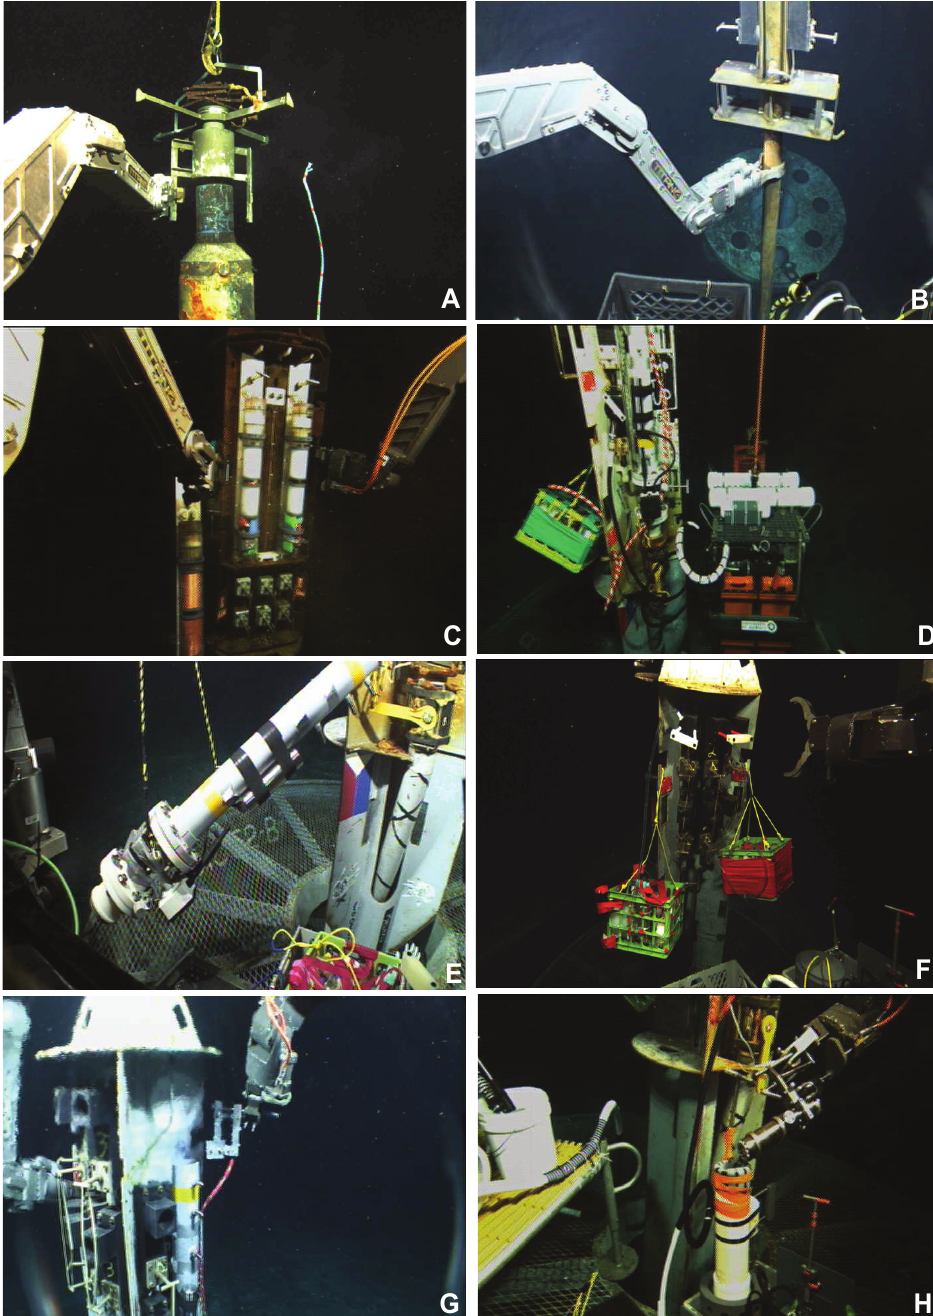
Figure 3. Photographs of CORK servicing activities during Expedition AT18-07. [A] Top Hat Extraction Tool deployed on old CORK wellhead in Hole 1027C. This tool is being used to remove an old electrical connector that was corroded in place, blocking access to the data logger. [B] Manifold insert being carried to CORK in Hole 1027C after removal of old connector and data logger. This tool has valves and fitting for pressure monitoring and a large ball valve and ring clamp (Fig. 2e) that can be used for later instrument deployments. [C] Exchanging OsmoSamplers on CORK in Hole U1301B. Samplers are (left to right): copper (gas tight), geochemistry (Teflon), microbiology. [D] OsmoSamplers in milk crate and GeoMICROBE sled deployed on ROV platform in Hole U1362B. [E] Flowmeter being lifted for deployment on Hole U1362B. [F] Multiple OsmoSampler crates deployed on CORK in Hole U1362A. [G] Fluid sampling inlet being deployed at top of chimney discharging shimmering hydrothermal fluids on Hole U1362B. [H] Gas-tight sampler being used with gas trap to collect fluids from Hole